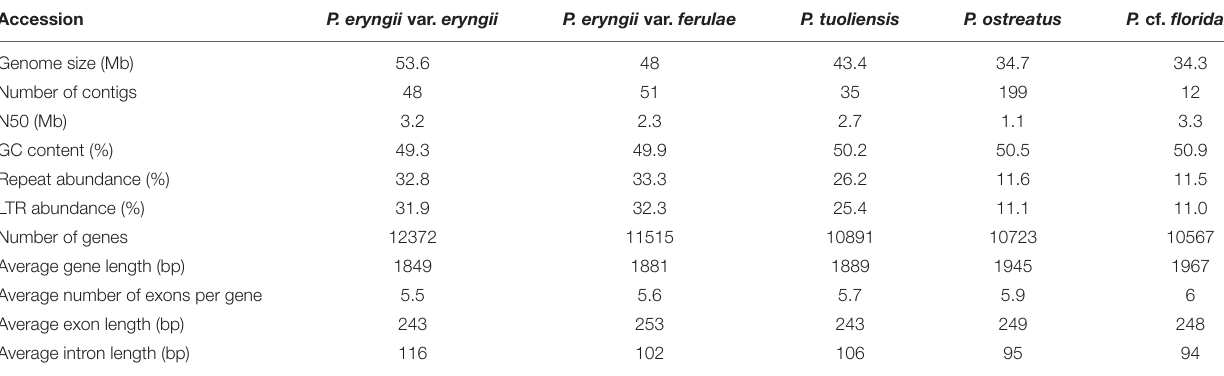
TABLE 1 | Genome assembly and annotation results of the five Pleurotus